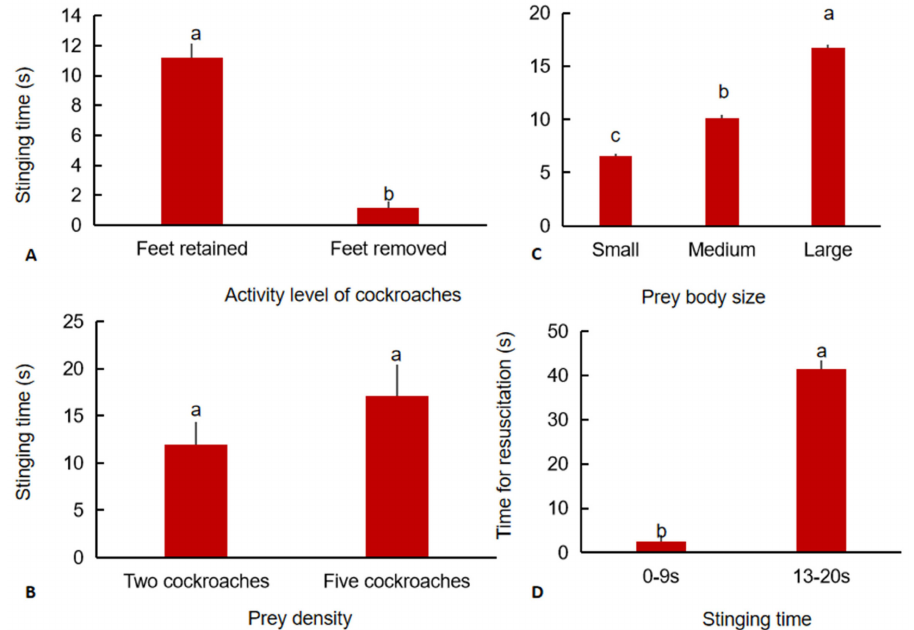
Figure 4. The effect of feet removal ( A ), density ( B ), and body size ( C ) of cockroaches on the stinging time of H. venator allocated to a single cockroach and the effect of stinging time on the recovery time of cockroaches ( D ) under laboratory conditions. Bars with the same letter are not significantly different at the 0.05 level (Kruskal–Wallis